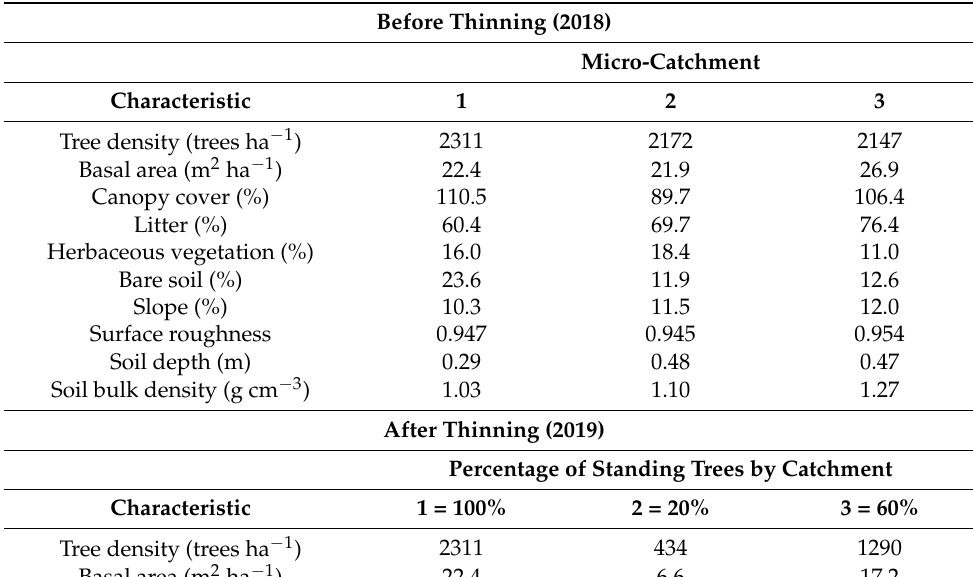
Table 2. Vegetation and soil characteristics before and after thinning.